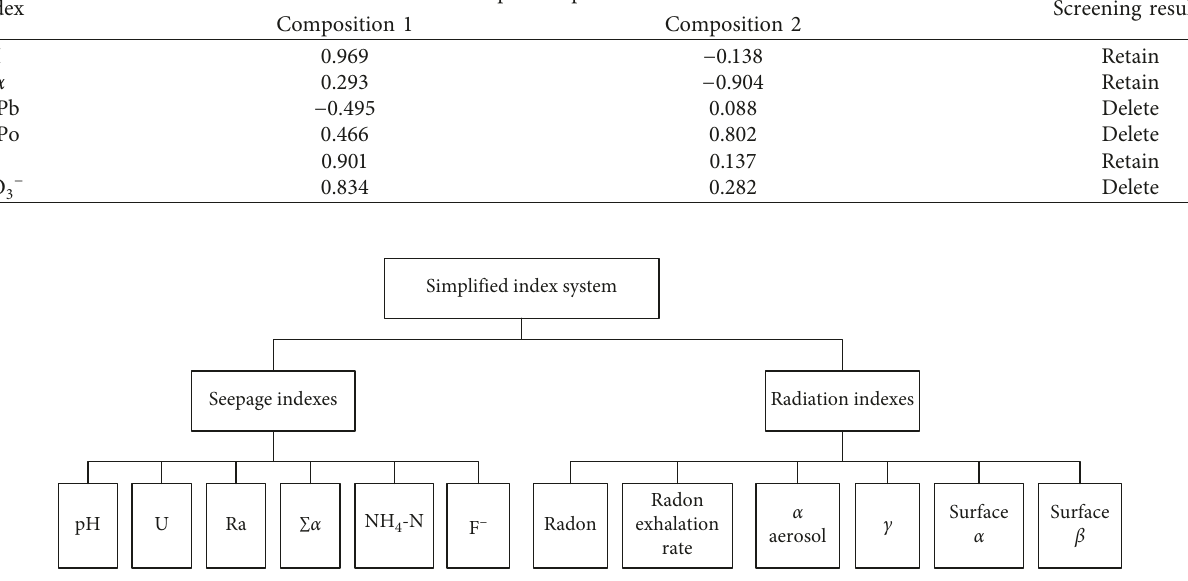
Figure 4: The sifted index system for environmental quality assessment in decommissioning uranium